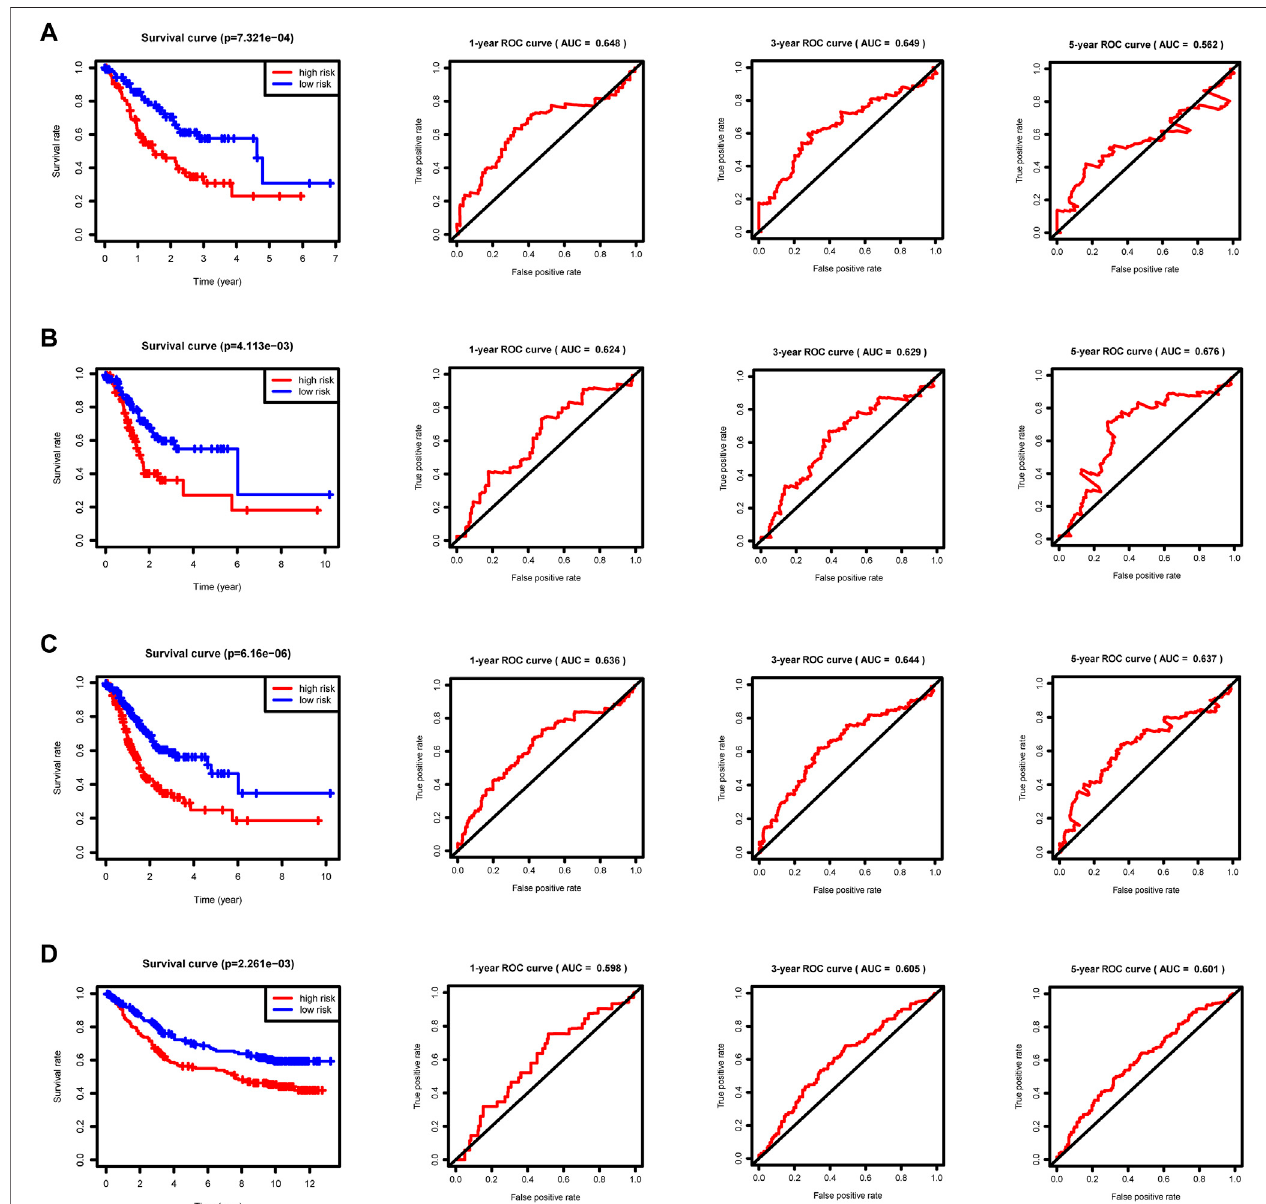
FIGURE 6 | Survival curves and ROC curves. p < 0.05 reveals signi fi cant survival differences. The ROC curves show the model prediction ef fi ciency. (A) Training group. (B) Internal validation group. (C) Total group. (D) External validation group GSE84433.